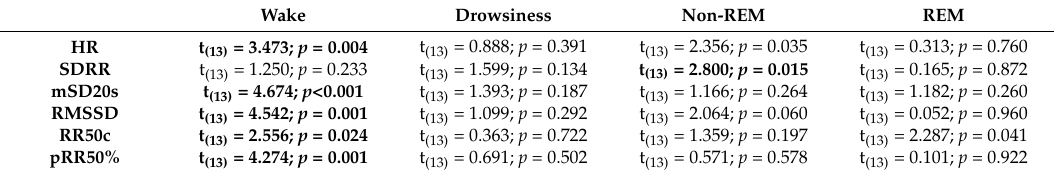
Table 5. Differences between ECG parameters following positive versus negative social interactions (5 min sampling from the first occurrence of a given sleep stage). Significant differences are highlighted with bold.